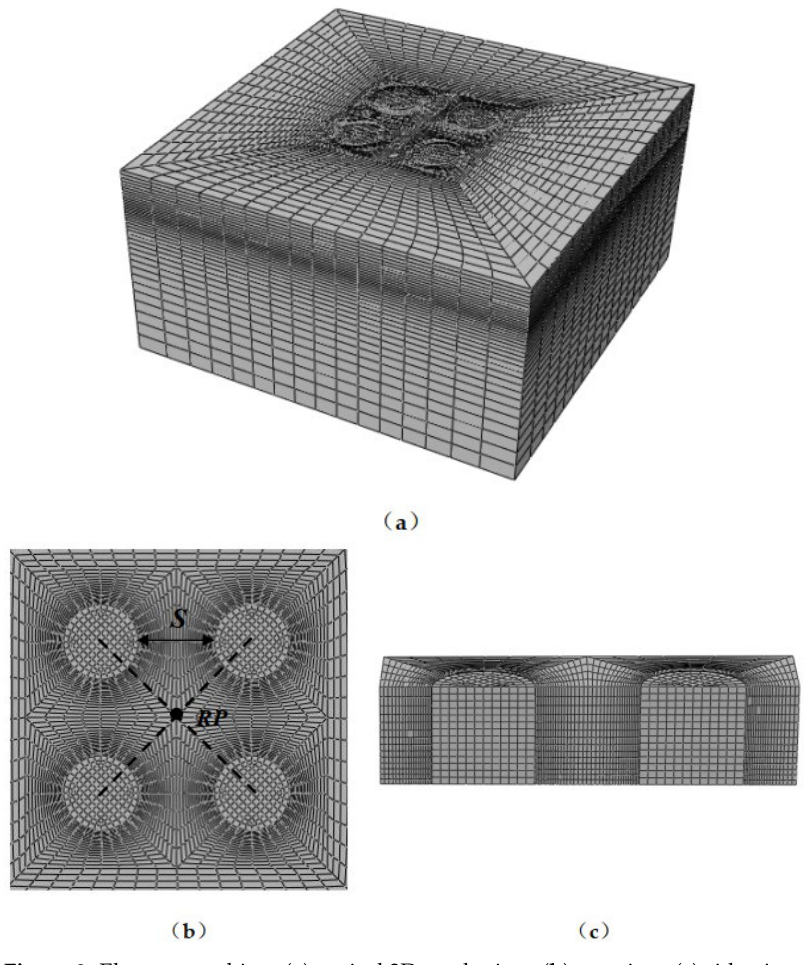
Figure 2. Element meshing: ( a ) typical 3D mesh view; ( b ) top view; ( c ) side view.